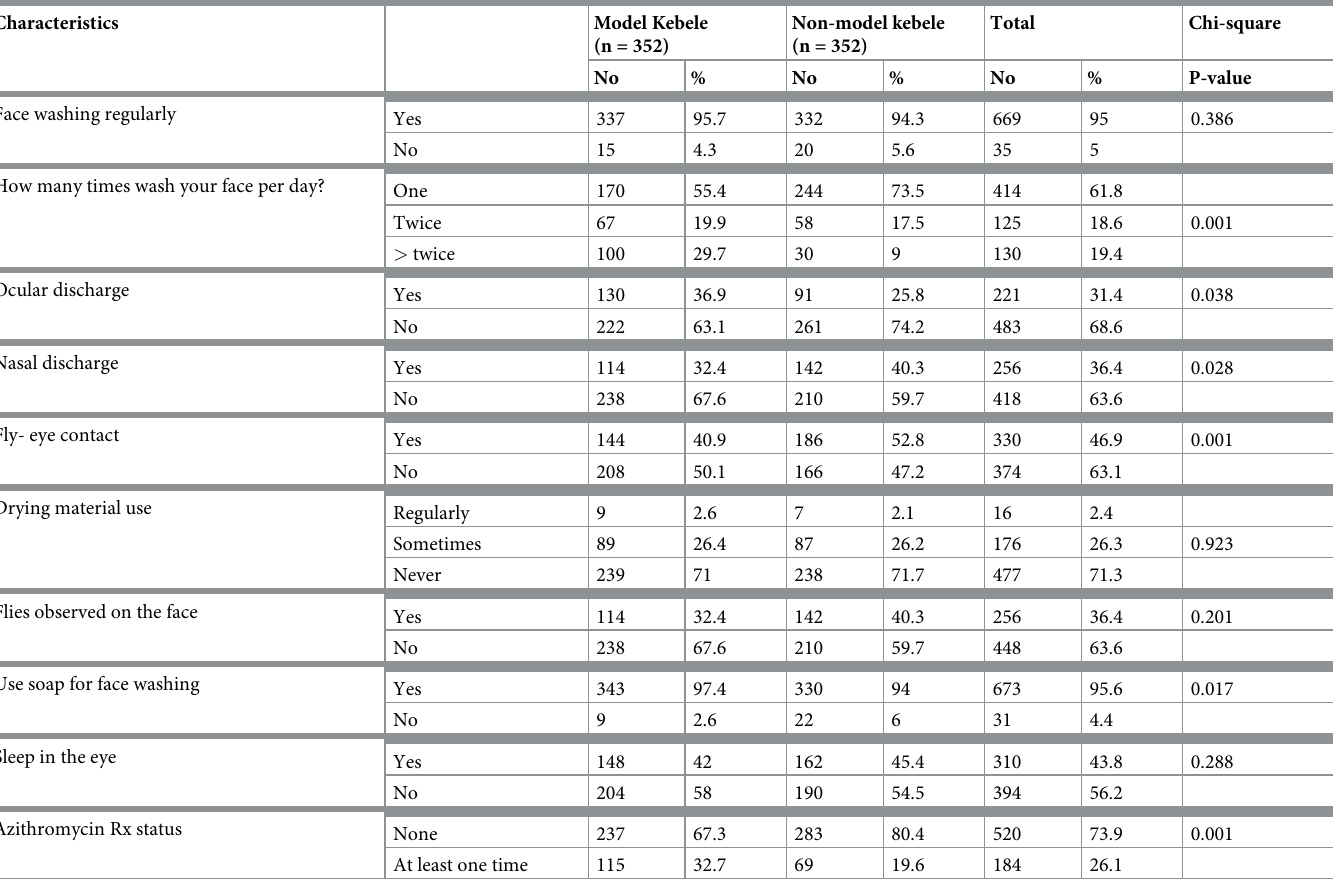
Table 3. Childhood behavioral factors in the model and non-model kebeles in Dangila district, northwest Ethiopia, 2019 (n = 704). Characteristics